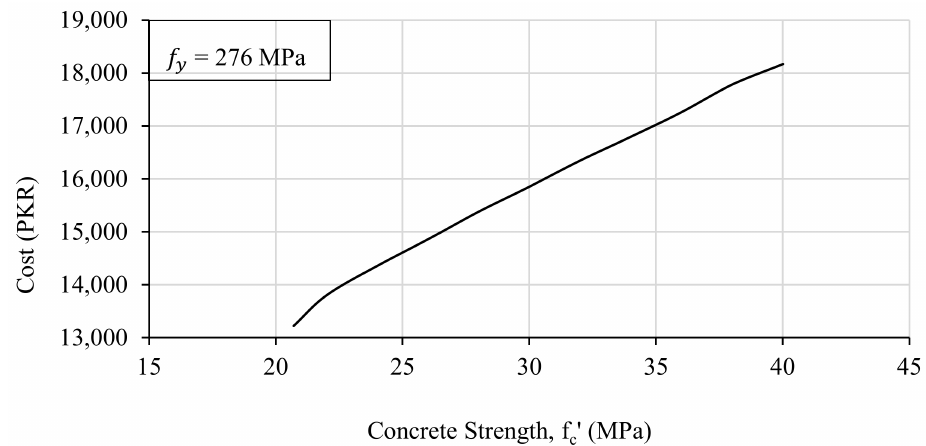
Figure 6. The effect of the concrete strength on the cost of the beam.